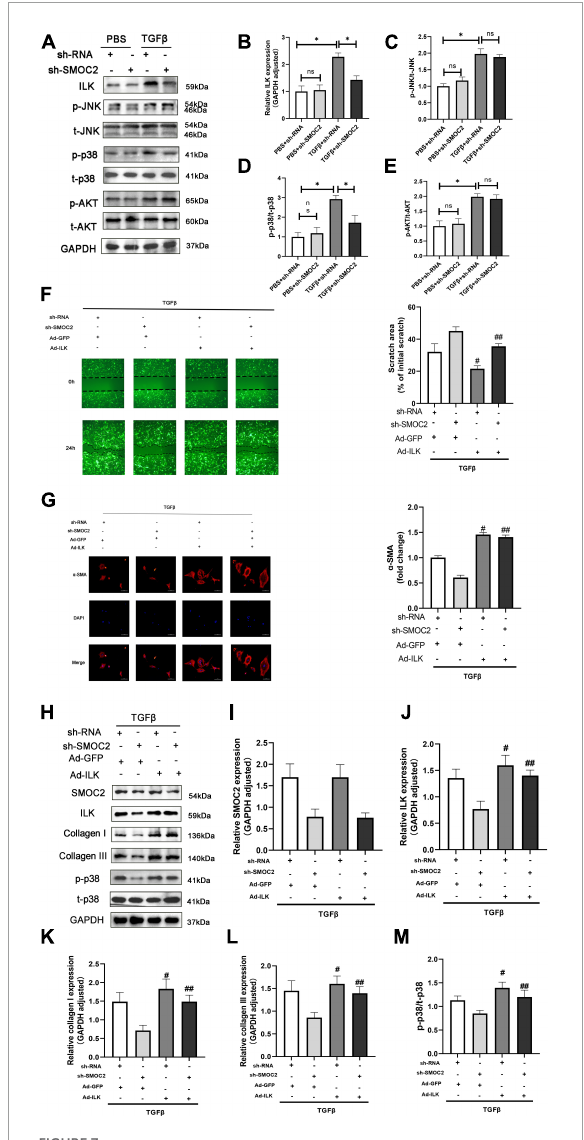
FIGURE7 Targeting SMOC2 expression ameliorates fibrosis via the ILK/p38 pathway in vitro . (A–E) Representative Western blots and quantitative results of ILK, t-AKT, p-AKT, t-JNK, p-JNK, t-p38, and p-p38 ( n = 6). ∗ p < 0.05 vs. the control + sh-RNA group. # p < 0.05 vs. the ISO + sh-RNA group. n.s., non-significant. (F) Representative images of the wound scratch assay post Ad-ILK infection. (G) Representative images of immunohistochemical staining for α -SMA ( n = 4). (H–M) Representative Western blots and quantitative results post Ad-ILK infection ( n = 3). ∗ p < 0.05. n.s., non-significant. # p < 0.05 vs. the sh-RNA + Ad-GFP group. ## p < 0.05 vs.